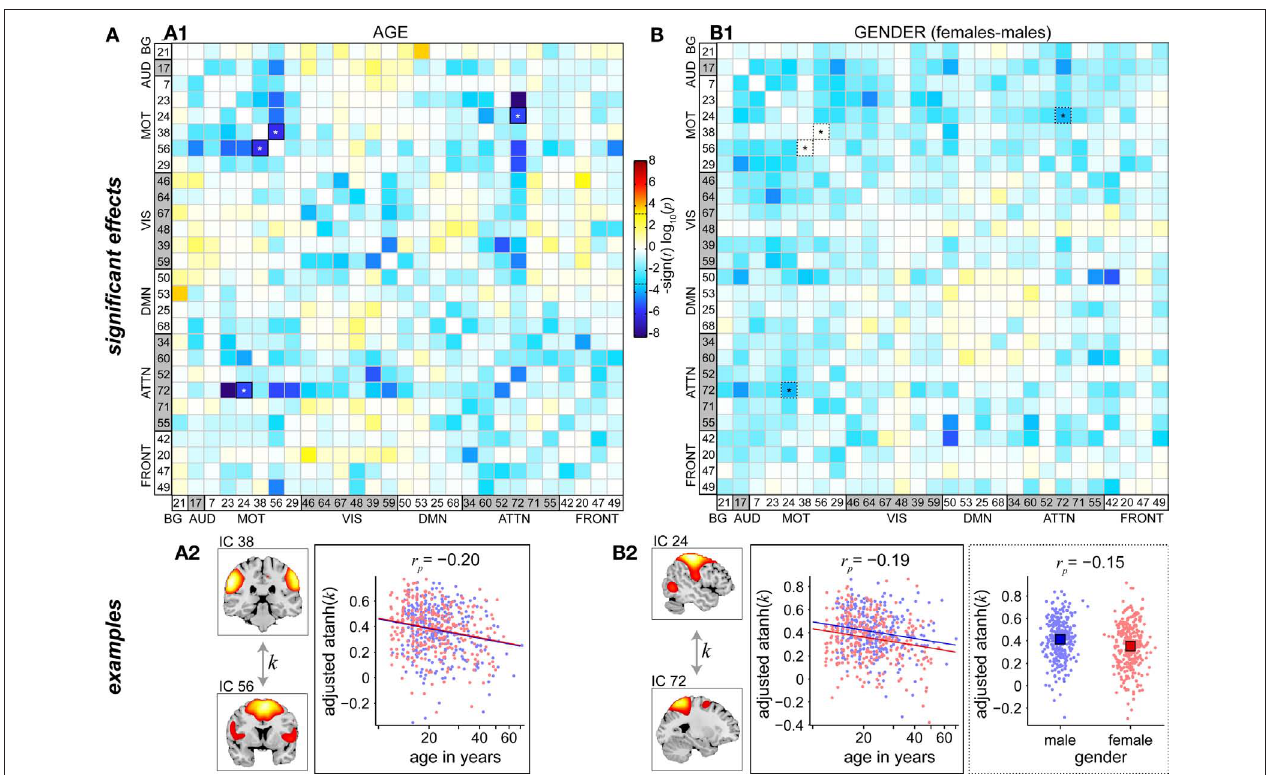
the FDR-corrected threshold ( a = 0.01). Bottom panels show examples of age FIGuRe 8 | univariate test results showing the effects age (A) and gender effects ( A2 , temporal correlation ( k ) between motor RSNs IC 38 and IC 56) and (B) on FNC, in a similar format to Figure 6. Top panels depict the significance both age and gender effects ( B2 , between motor RSN IC 24 and precuneus RSN and direction of age (A1) and gender (B1) terms for each pairwise correlation, IC 72). FNC examples are highlighted in panels (A1,B1) by displayed as the − sign( t )log ( p ). Dashed horizontal lines on the colorbar designate 10